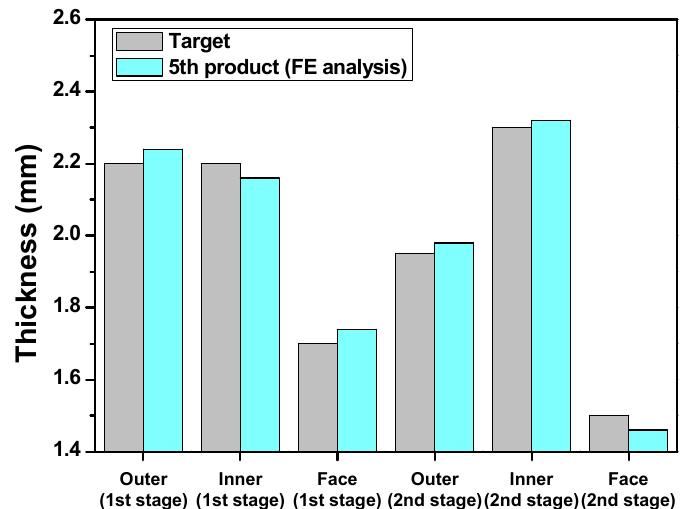
Figure 9. The predicted thickness for the 5th product.